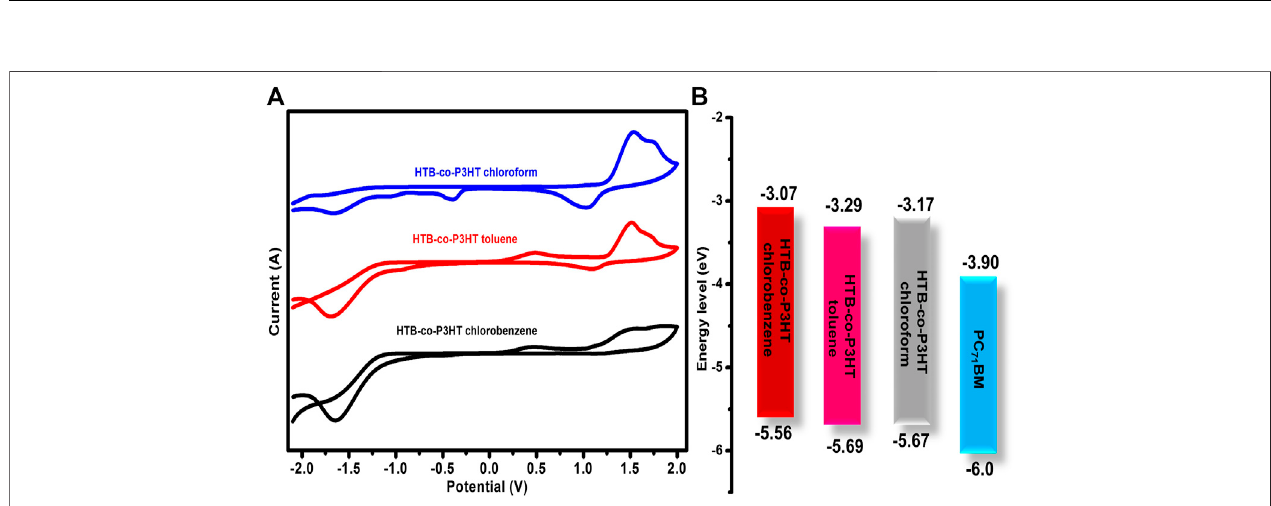
FIGURE 9 | (A) Cyclic voltammograms of HTB-co-P3HT prepared in different solvents and (B) the energy levels compared with PC 71 BM energy levels.